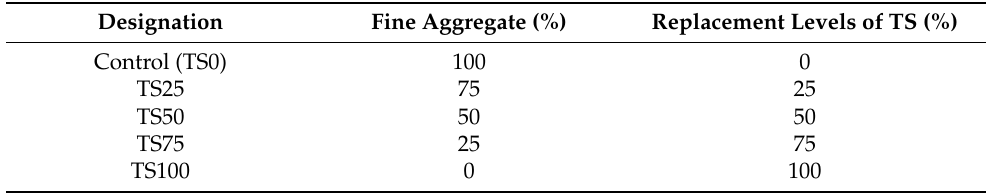
Table 3. The mix percentages of tin slag (TS) in mortar.